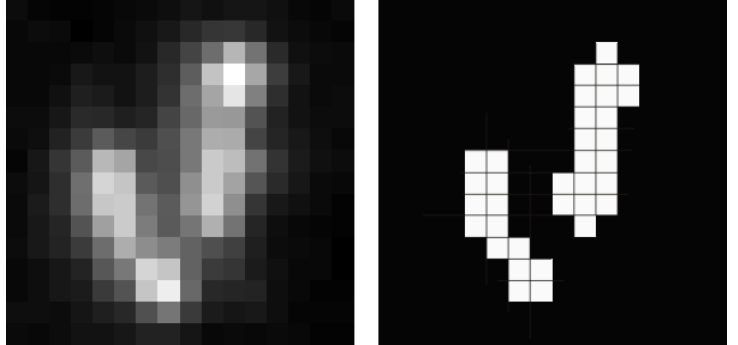
Figure 4. Sample image including 2 ants: (left) grayscale image, (right) binary image.